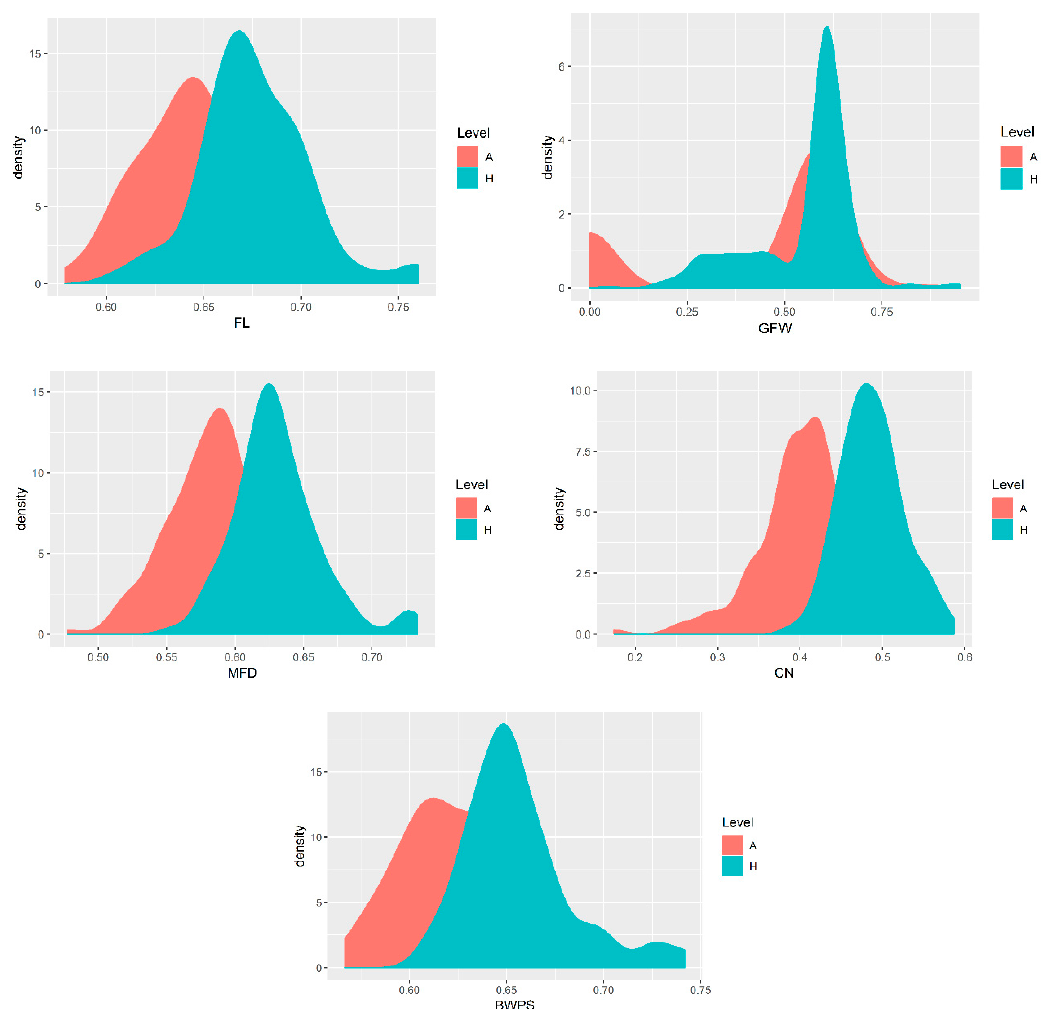
Figure A1. Density map of breeding value accuracy for di ff erent traits in genotyped animals under di ff erent matrices: pedigree-based approach (A, PBLUP) and combined pedigree and genomic information-based approach (H, ssGBLUP).